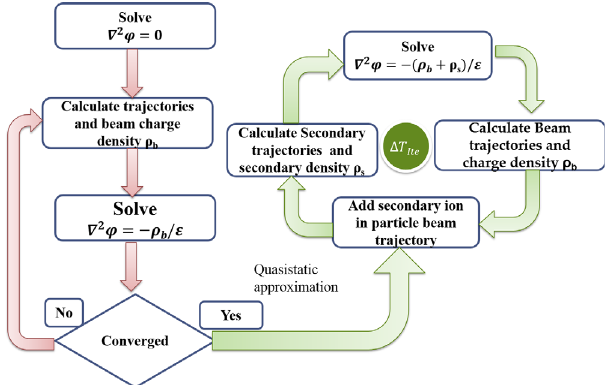
FIG. 2. Flow diagram of the beam plasma model in IBSimu for space charge compensation simulations using secondary particles instead of a reduced beam net